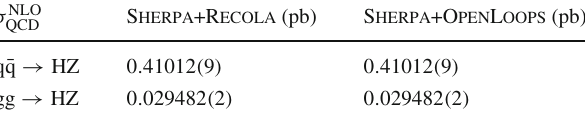
Table7 Totalcrosssectionscalculatedforpp → HZatNLOQCDwith the Sherpa + Recola interface,comparedagainst Sherpa +O pen L oops